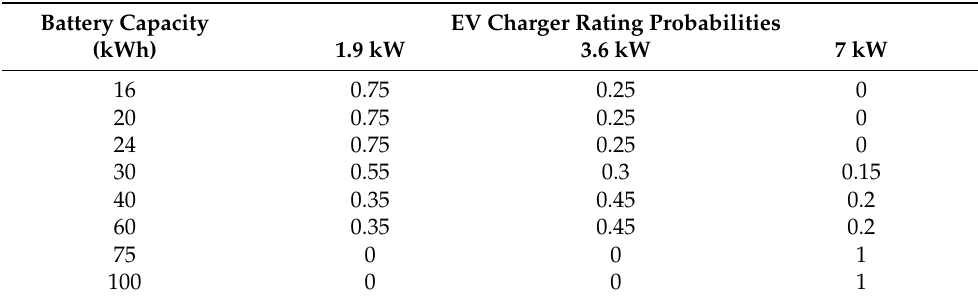
Table 8. Probability distributions of charger rating as a function of battery capacity for single phase